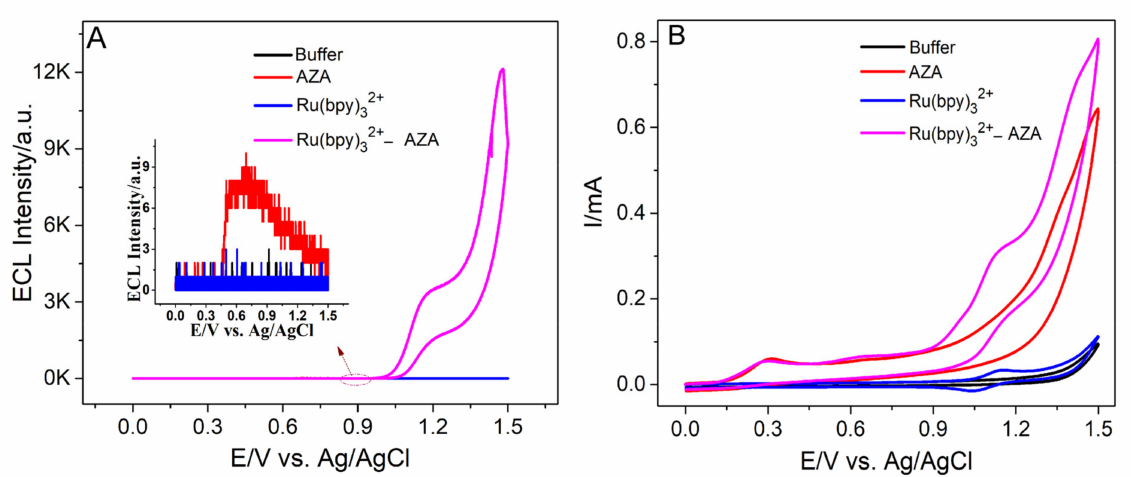
Figure 1. ( A ) ECL signal vs. potential and ( B ) cyclic voltammograms of buffer, 1 mM AZA, 0.5 mM Ru(bpy) 32+ , 1 mM AZA/0.5 mM Ru(bpy) 32+ Carried out at GCE in 0.1 M PBS (pH 8.5); scan rate = 100 mV/s, PMT = 900 V. The inset is ECL curves of the buffer, AZA, and Ru(bpy) 3 2+ .